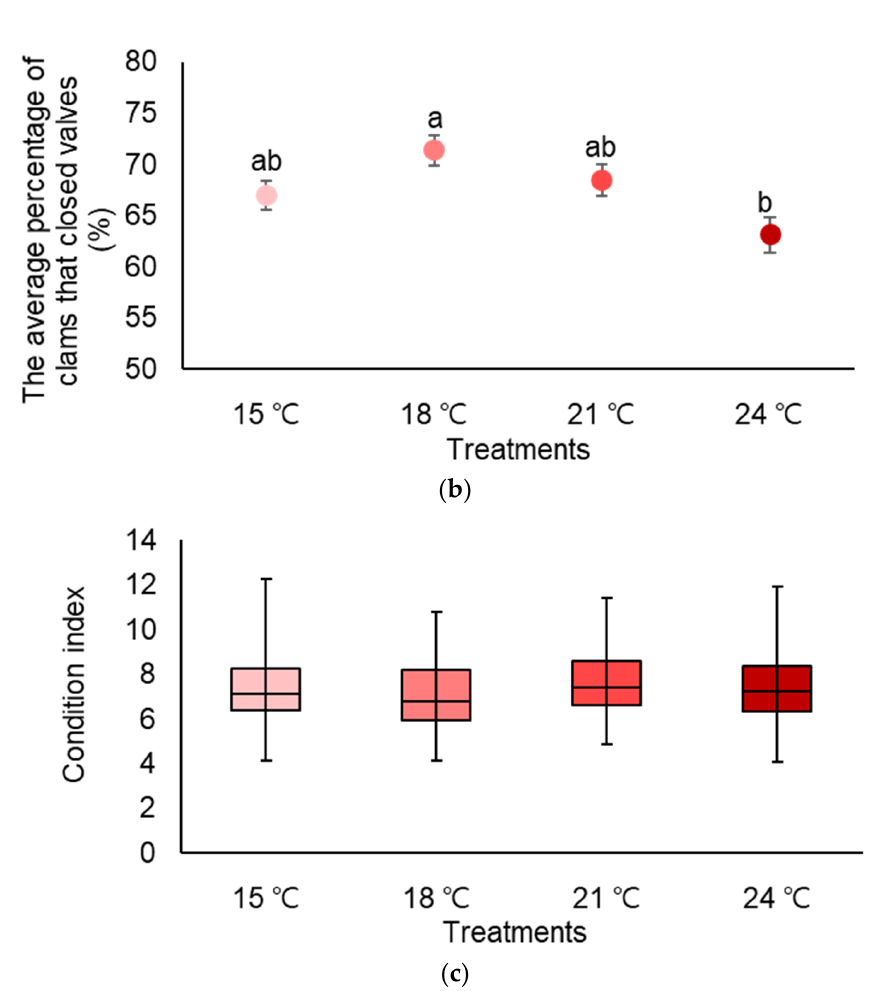
Figure 3. ( a ) Cumulative mortality rate (mean ± SE), ( b ) the average proportion of valve closure (mean ± SE), and ( c ) condition index (mean ± SE) of Venerupis philippinarum during exposure to different temperatures (15 °C, 18° C, 21 °C, and 24 °C) for 15 days. Different letters indicate significant differences between treatments ( p < 0.05).